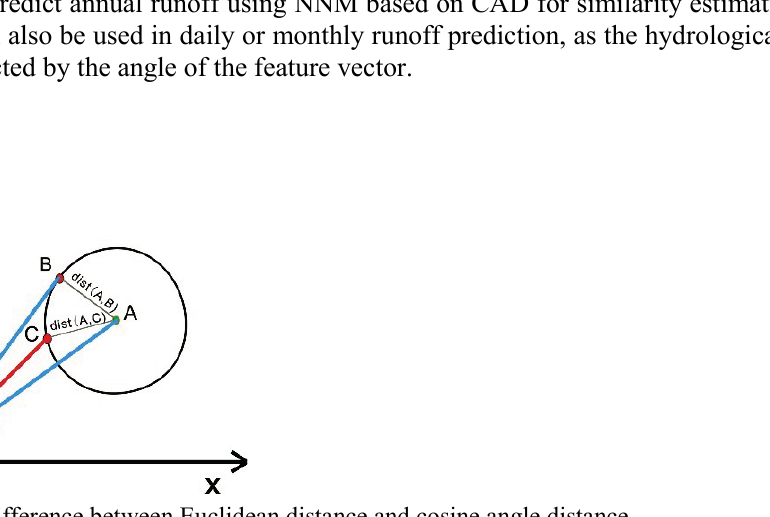
Fig. 1 Difference between Euclidean distance and cosine angle distance.